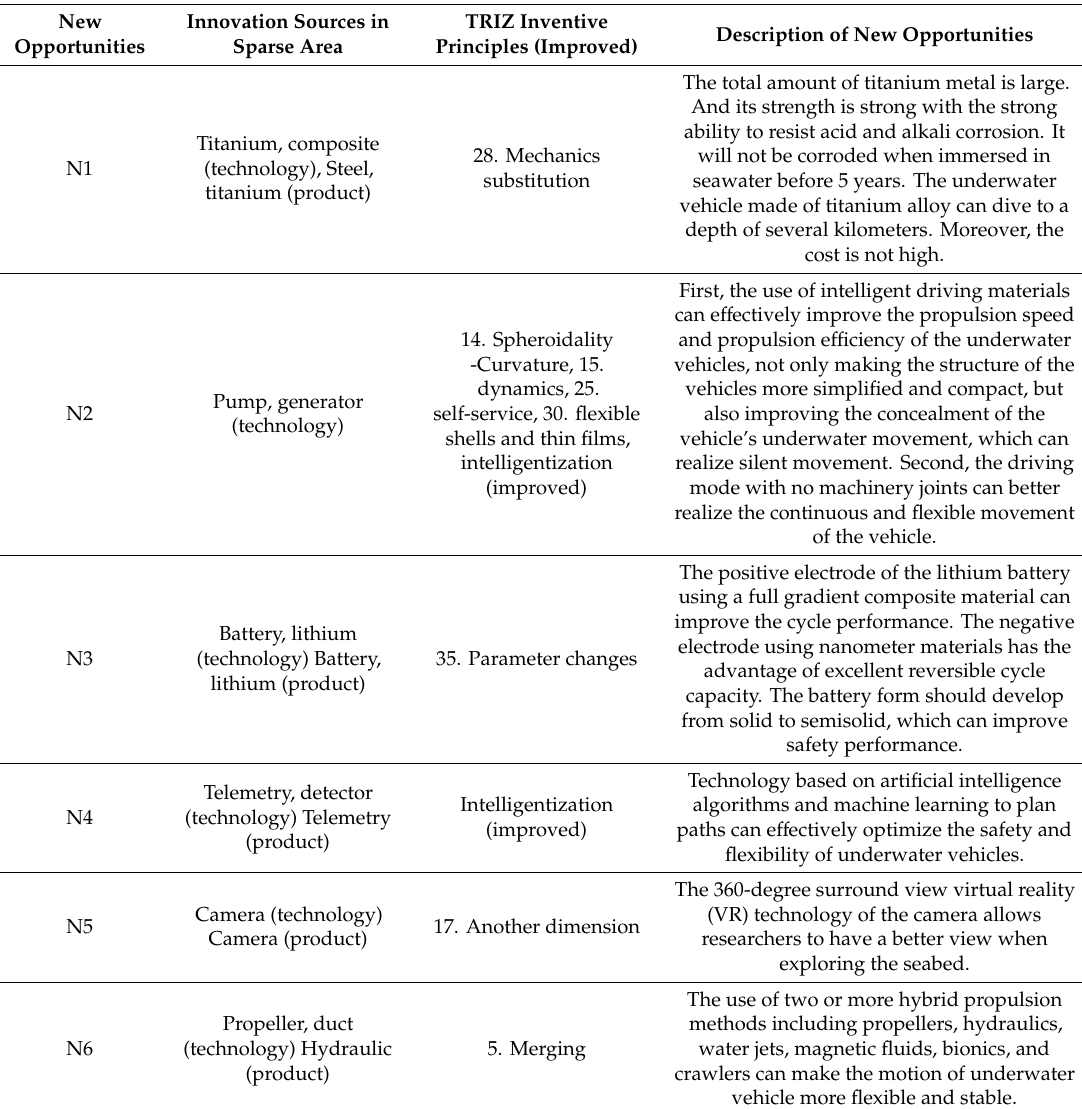
Table 11. New opportunities discovered by integrating TRIZ inventive